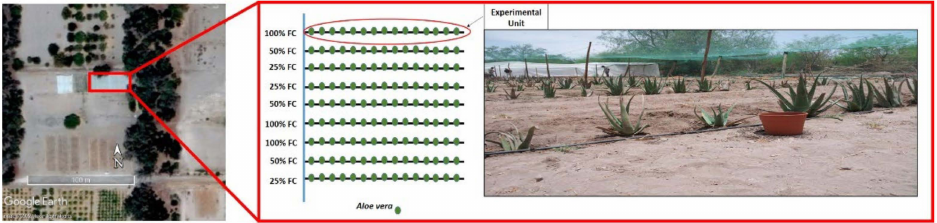
Figure 1. Aerial view of the study site (20 ◦ 26 (cid:48) 37.74” S, 69 ◦ 32 (cid:48) 09.50” W) with a schematic represen- tation of the 250 m 2 field experiment and a close-up of the experimental units analyzed in this study (details of the experimental design are in the Section